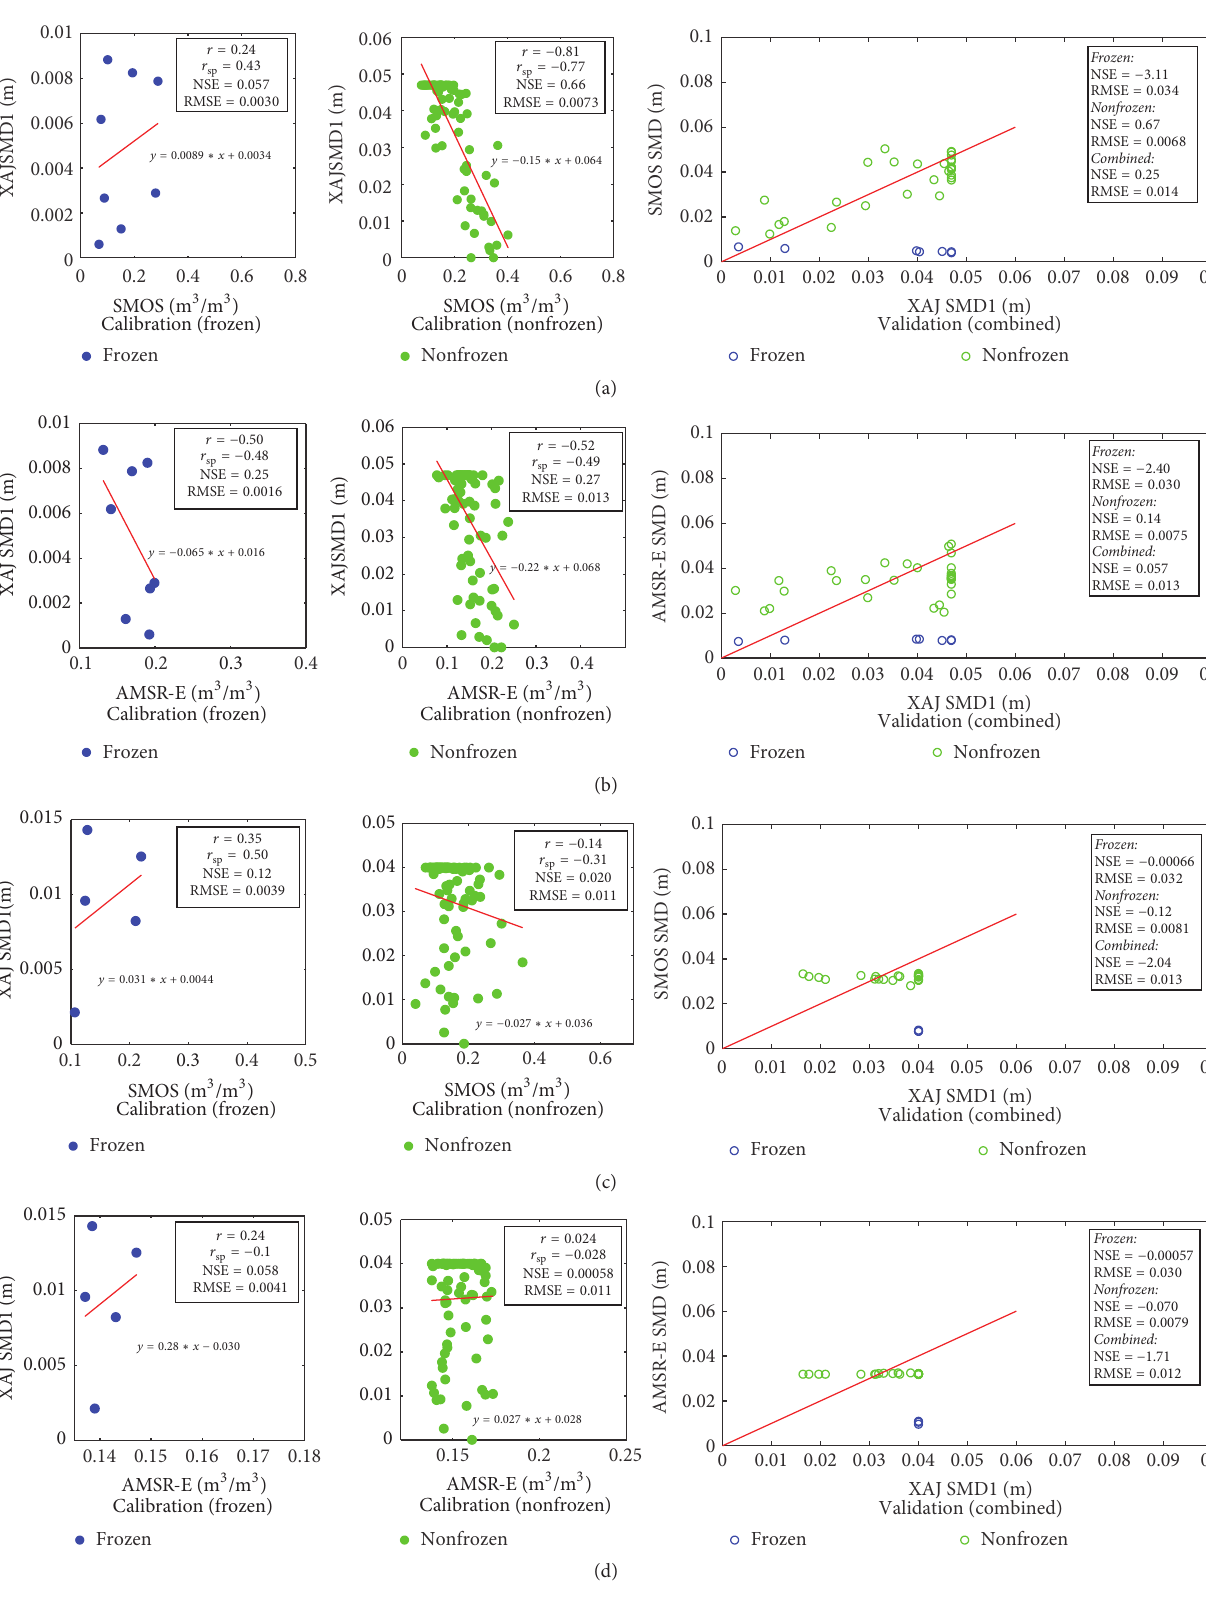
Figure 7: The calibration and validation results using temperature-based discrimination approach. For PB the performance of SMOS derived SMD (a) and AMSR-E derived SMD (b) are presented. For FBB the performance of SMOS derived SMD (c) and AMSR-E derived SMD (d) is shown. It is important to note that, for the calibration, the calculated NSE and RMSE are between the XAJ SMD1 and the satellites’ derived SMD during the calibration period; therefore all the RMSEs shown here are in the unit of